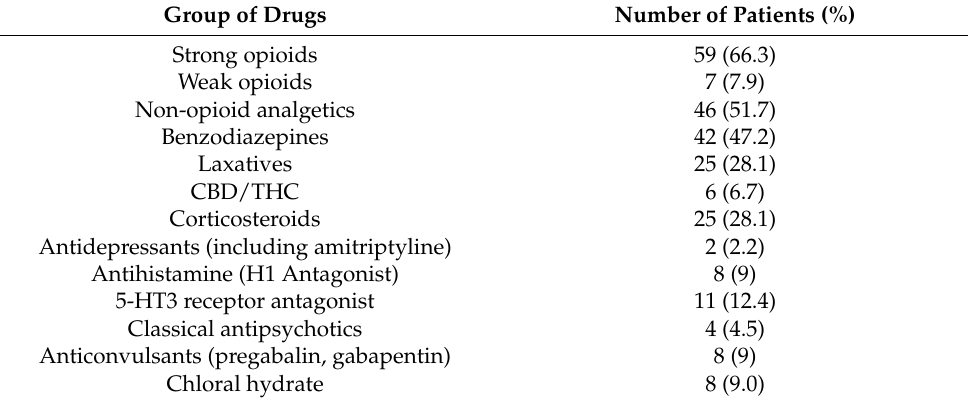
Table 2. Medication in the terminal